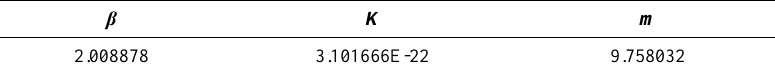
Table 9. Regression parameters for IPL-Weibull